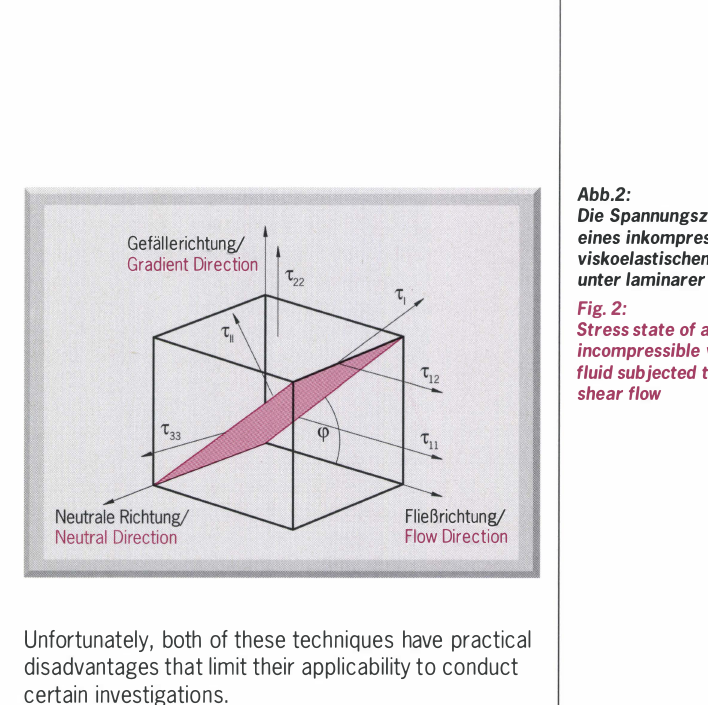
Fig.2: Stress state of an incompressible viscoelastic fluid subjected to laminar shear